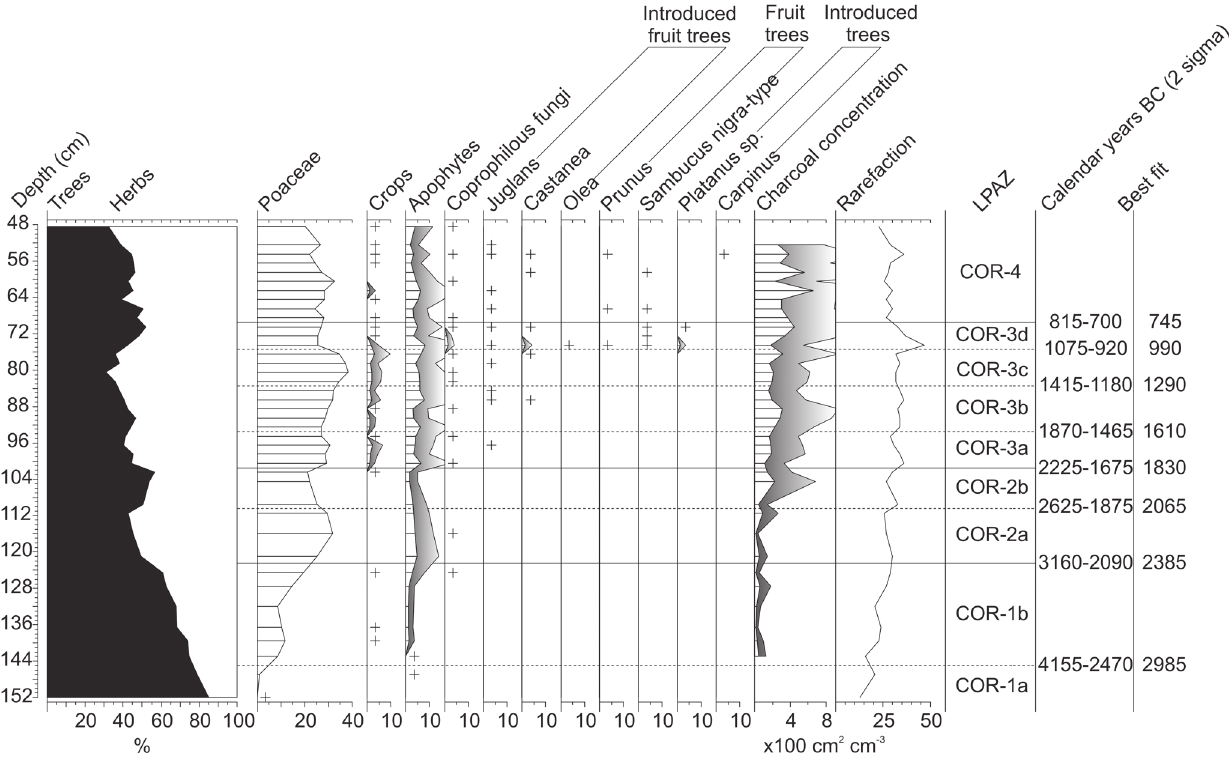
Fig 10. Summary diagram displaying selected taxa, summary curves of crops, apophytes (sum of taxa labeled apophytes in Fig. 7) and coprophilous fungi, Charcoal concentration and rarefaction index are also displayed. + indicates < 1% TLP and where present exaggeration curves are x3. Ages for the LPAZ boundaries reflect two sigma modeled age ranges with the best fit age derived from the smoothed spline CLAM